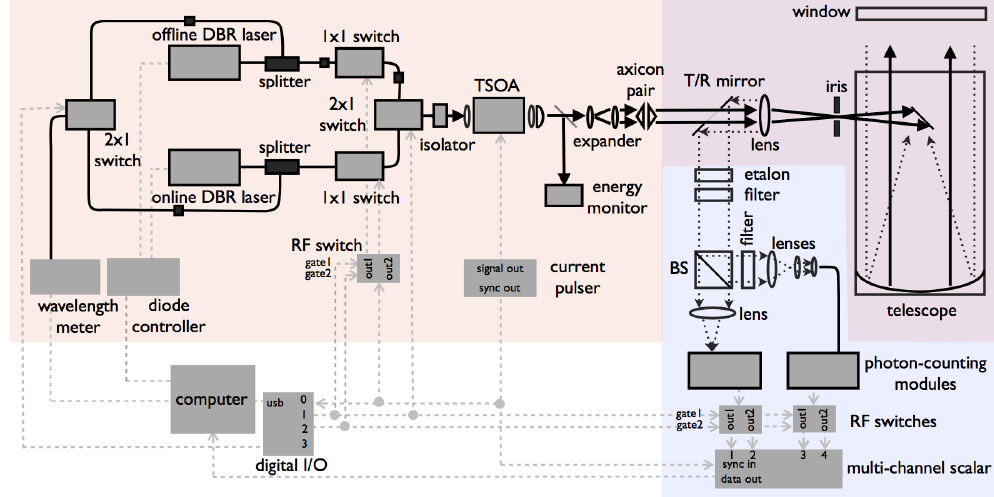
Figure 1. Schematic of the WV-DIAL system. BS is the beam splitter, T/R is transmit/receive, and I/O is input/output.